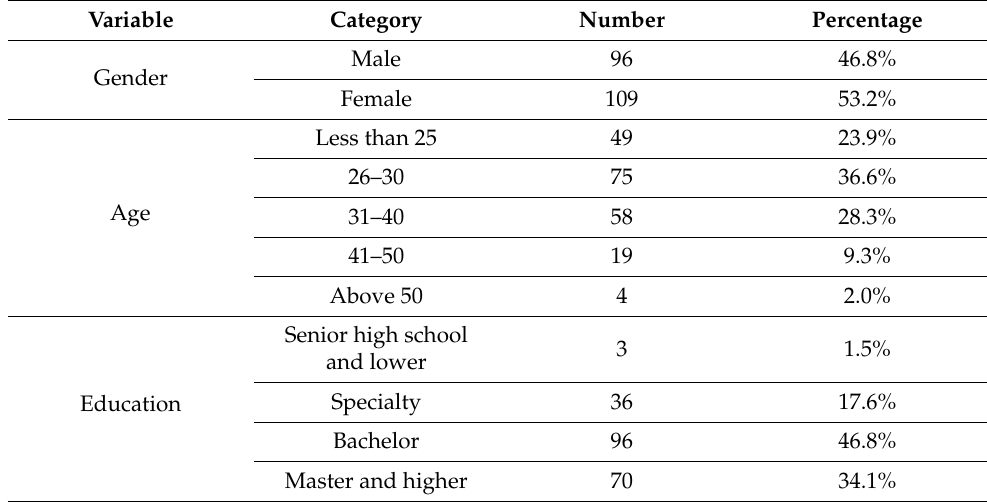
Table 1. Demographic.